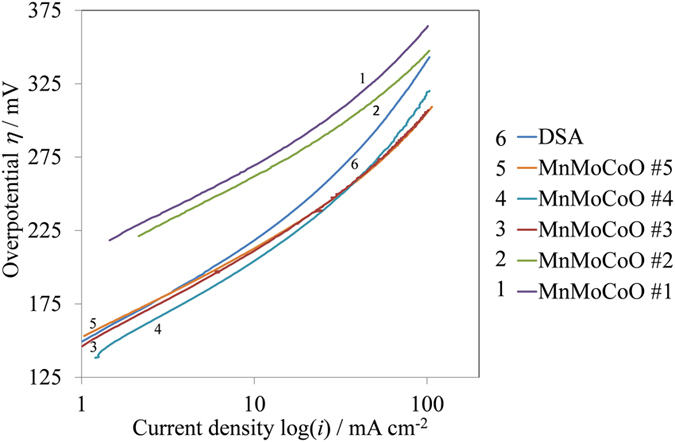
Tafel plot of the modified EMD samples in 2 M H2SO4 solution.